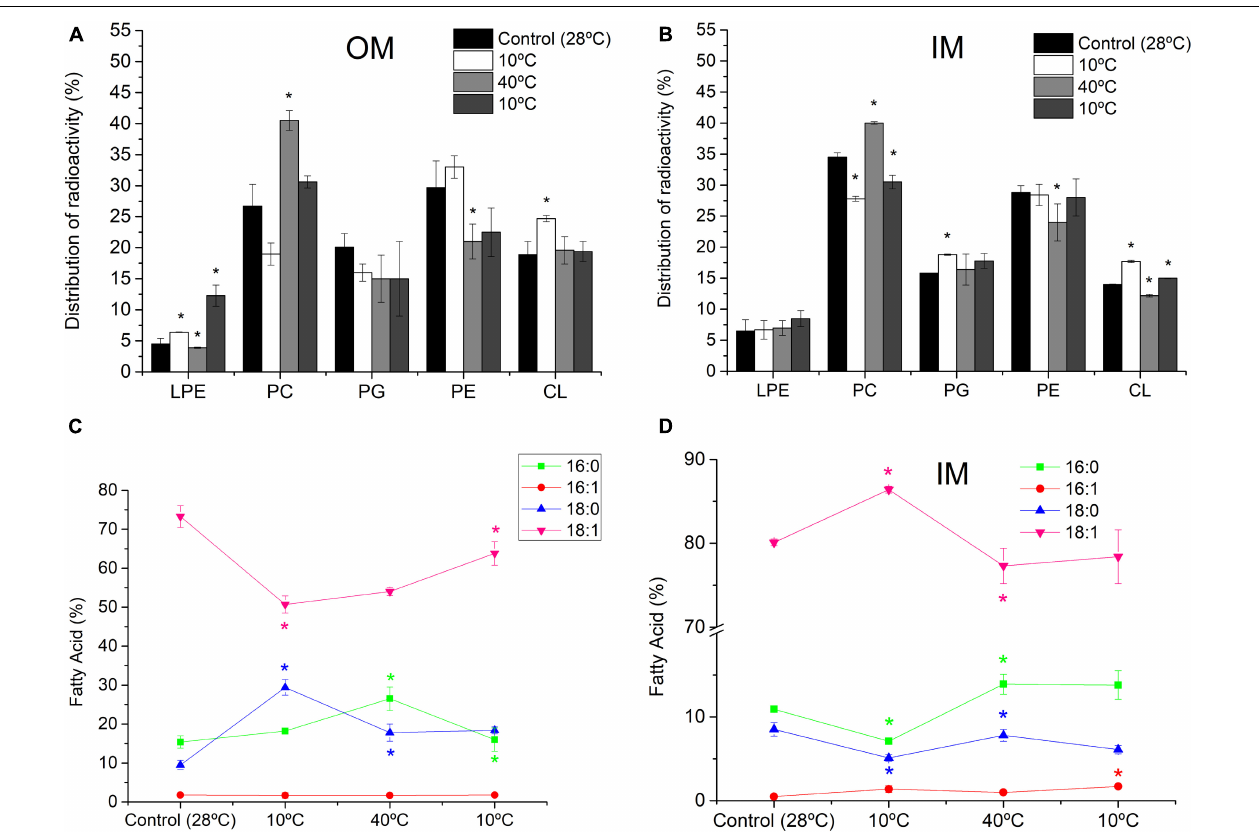
FIGURE 4 | Effect of cyclic temperature variations on the composition of PL and FA from S. meliloti OM (A,C) and IM (B,D) . S. meliloti culture (200 mL) with or without [ 14 C]-acetate was grown to a stationary phase at 28 ◦ C and then the thermal changes applied (10 ◦ C–40 ◦ C–10 ◦ C) every 24 h incubation period. After exposure to each temperature, a 50 mL aliquot of culture was separated and the biomass used to obtain OM and IM fractions. Panels (A,B) data from TLC of radioactively labeled PL bands scraped and quantified by liquid scintillation counting. Panels (C,D) GC-MS analysis FAME from total lipids. The percentage of each FA and PL is relative to the total defined as 100%. Values represent the mean ± sd of three independent experiments. Asterisks indicate statistically significant changes with respect to the previous stage.